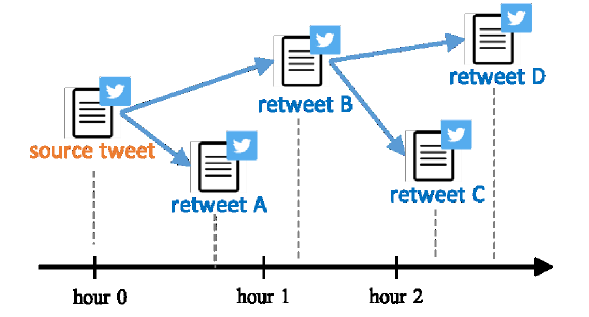
Figure 1. An example of information cascade on Twitter.